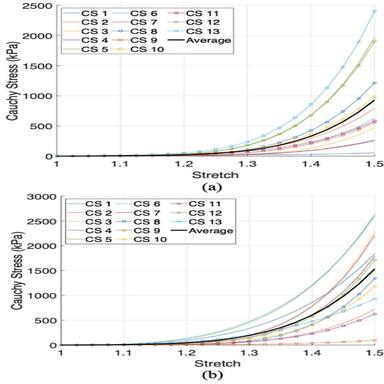
Material behavior of the fibrous intima (a) and wall (b) layers based on the iFEM results under uniaxial tensile testing conditions of thought experiments.